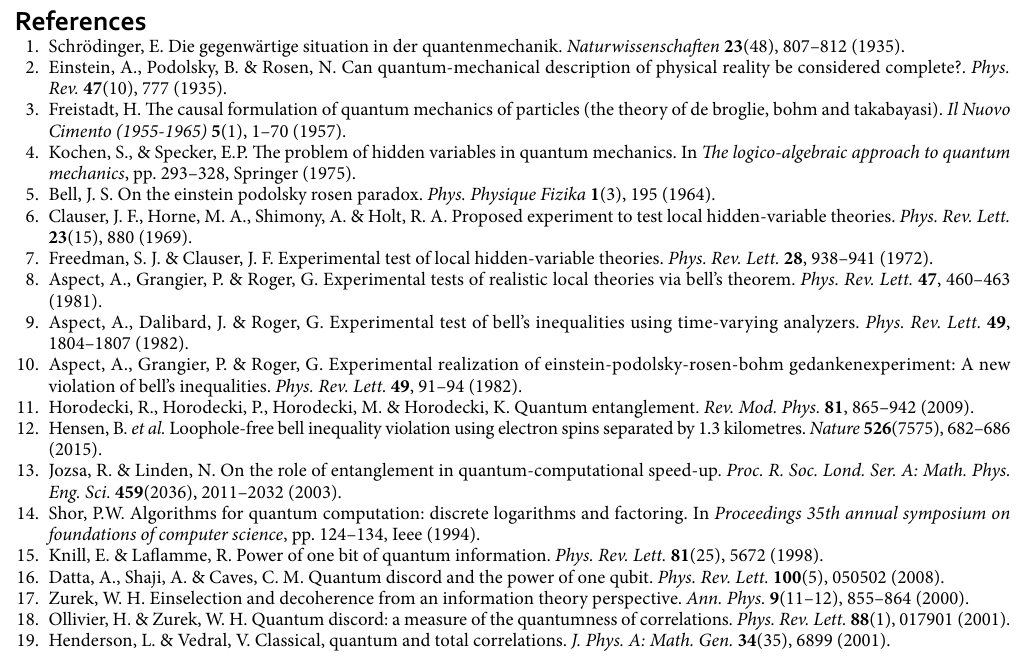
Figure 10. EA compared with entanglement and discord for 10